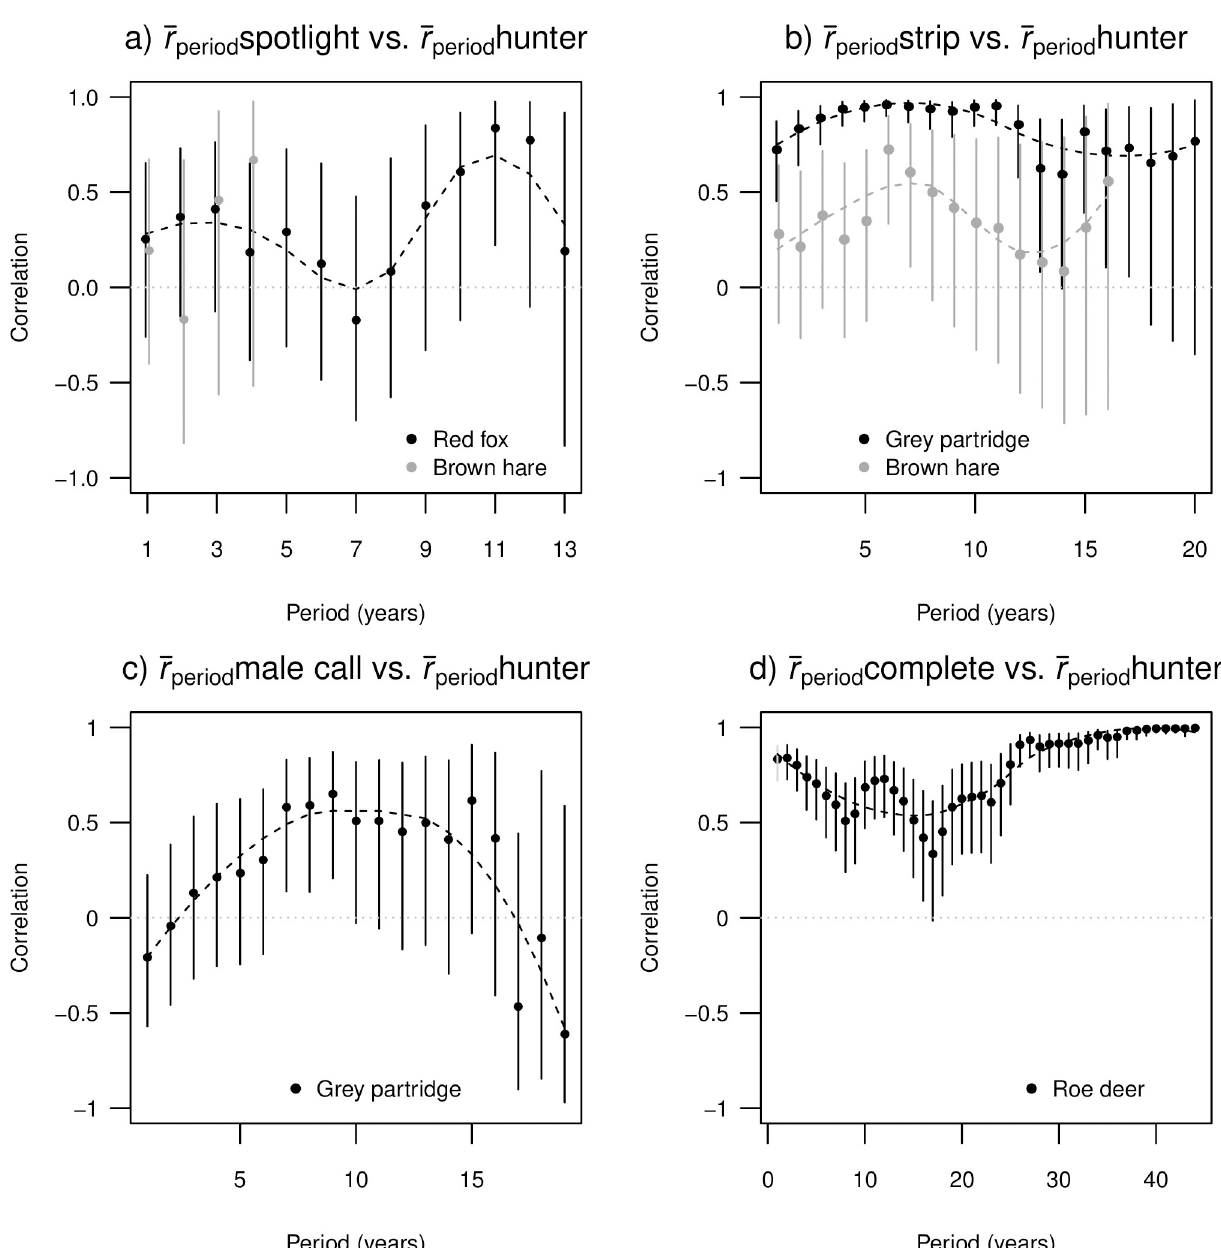
Fig 4. The correlation with 95% confidence intervals between period mean realized intrinsic growth rates ( � r � period mean realized intrinsic growth rates based on estimates derived by other targeted survey methods as a function of period length. The dashed line represents a fitted loess smoother to facilitate depicting of apparent trends. Dotted line depicts zero correlation. Period 1 year corresponds to annual growth rates ( r ), see Fig 3 for detailed t